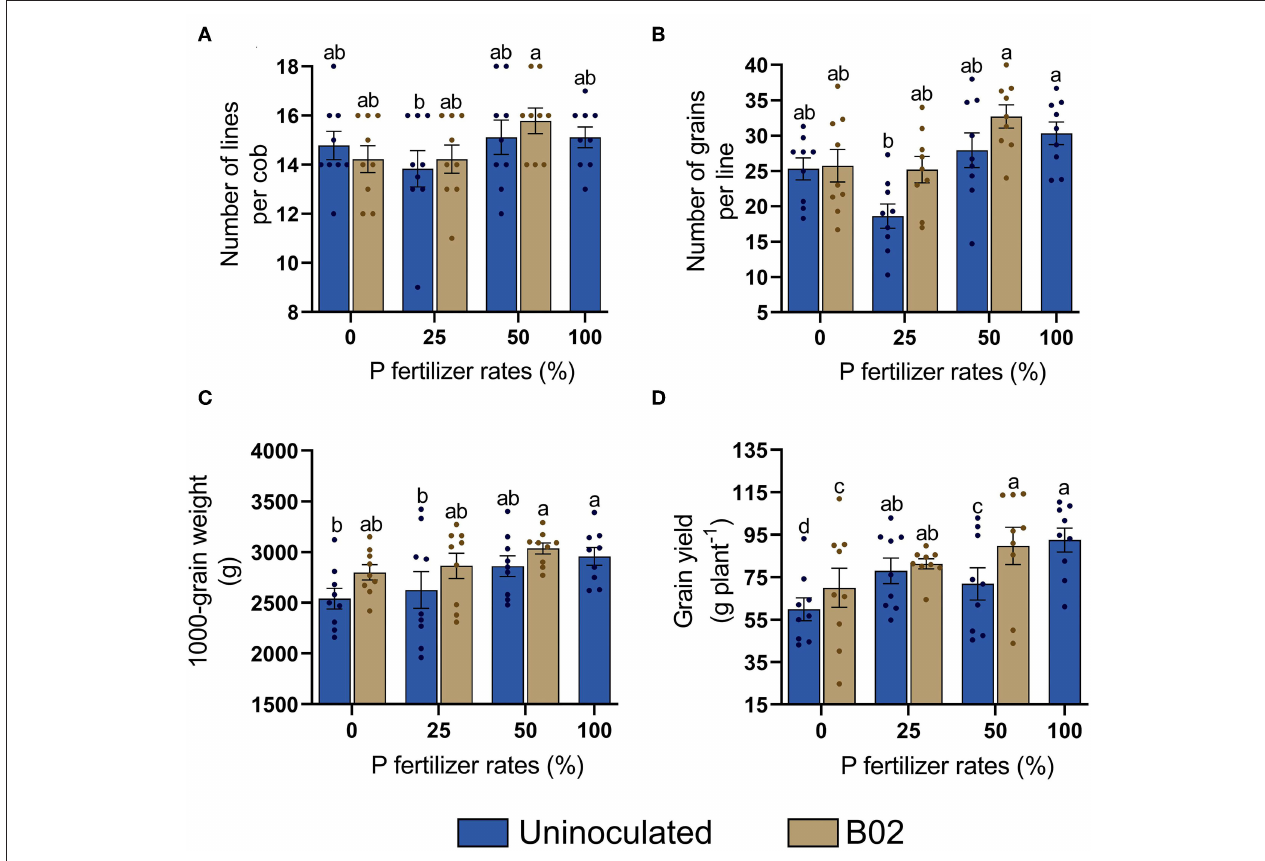
FIGURE 3 | Influence of inoculation with Rhizobium sp. B02 on the number of lines per cob (A) , number of grains per line (B) , 1,000-grain weight (C) , and grain yield (D) of the white endosperm genotype of maize at the reproductive stage of physiological maturity. Means and standard errors result from three replicates and three independent repetitions. Different letters are indicators of significant differences according to Tukey’s test ( p <